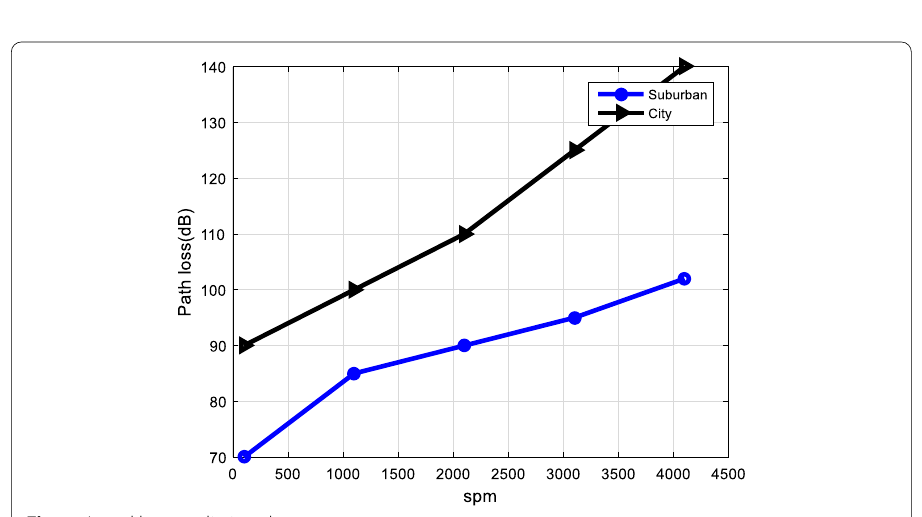
Fig. 4 Actual loss prediction